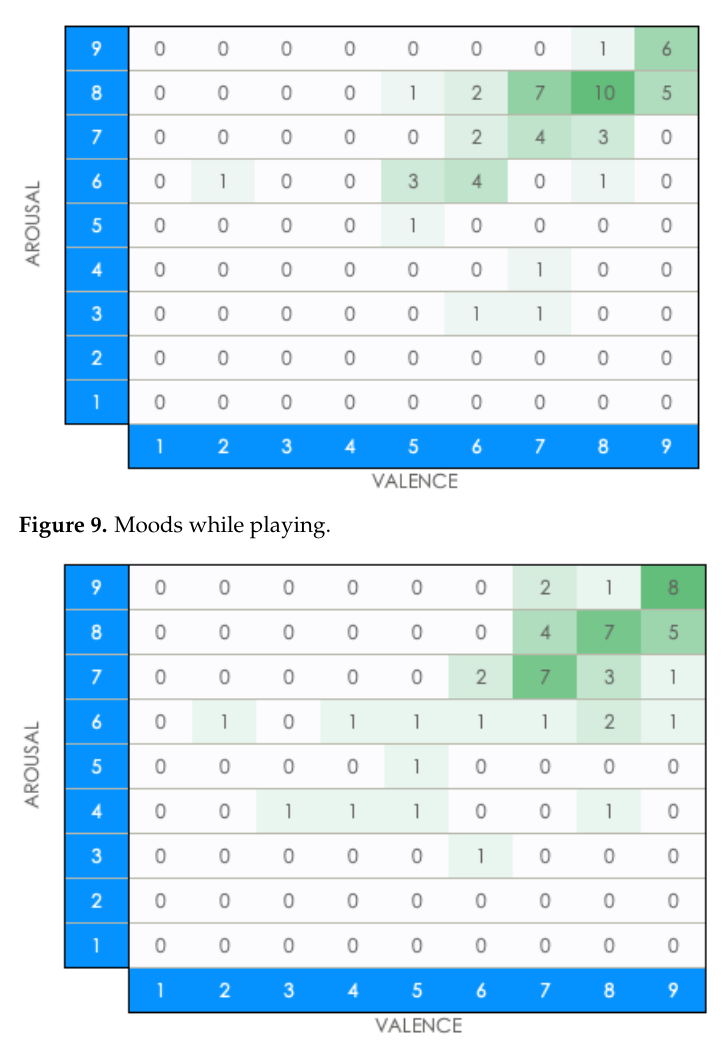
Figure 8. Moods when starting to play.